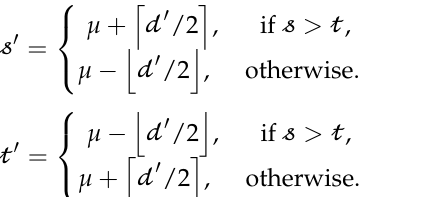
( b ) Figure 5. Flowcharts of the embedding and the extraction stages; ( a ) Flowchart of the embedding stage; ( b ) Flowchart of the extraction stage. 3.1. Data Embedding Stage After determining the type of all blocks, all the blocks 𝔹(𝓈, 𝓉),1 < 𝓈 < (ℳ − 1), 1 < 𝓉 < (𝒩 − 1) are processed in the raster scan order. When the block 𝔹(𝓈, 𝓉) is to be processed, its corresponding upsampled vacated block ℂ(2𝓈 − 1: 2𝓈 + 1,2𝓉 − 1: 2𝓉 + 1) serves as the current processing unit. Depending on the block type of (𝓈, 𝓉) , two different data embedding processes for complex blocks and smooth blocks are presented as Figure 5. Flowcharts of the embedding and the extraction stages; ( a ) Flowchart of the embedding stage; ( b ) Flowchart of the extraction stage. Figure 5. Flowcharts of the embedding and the extraction stages; ( a ) Flowchart of the embedding Figure 5. Flowcharts of the embedding and the extraction stages; ( a ) Flowchart of the embedding stage; ( b ) Flowchart of the extraction stage. stage; ( b ) Flowchart of the extraction stage.